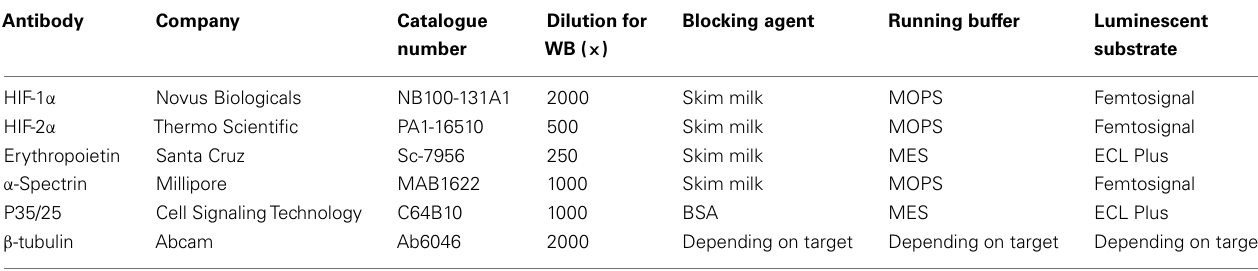
Table 1 | Overview of antibodies used for western blots